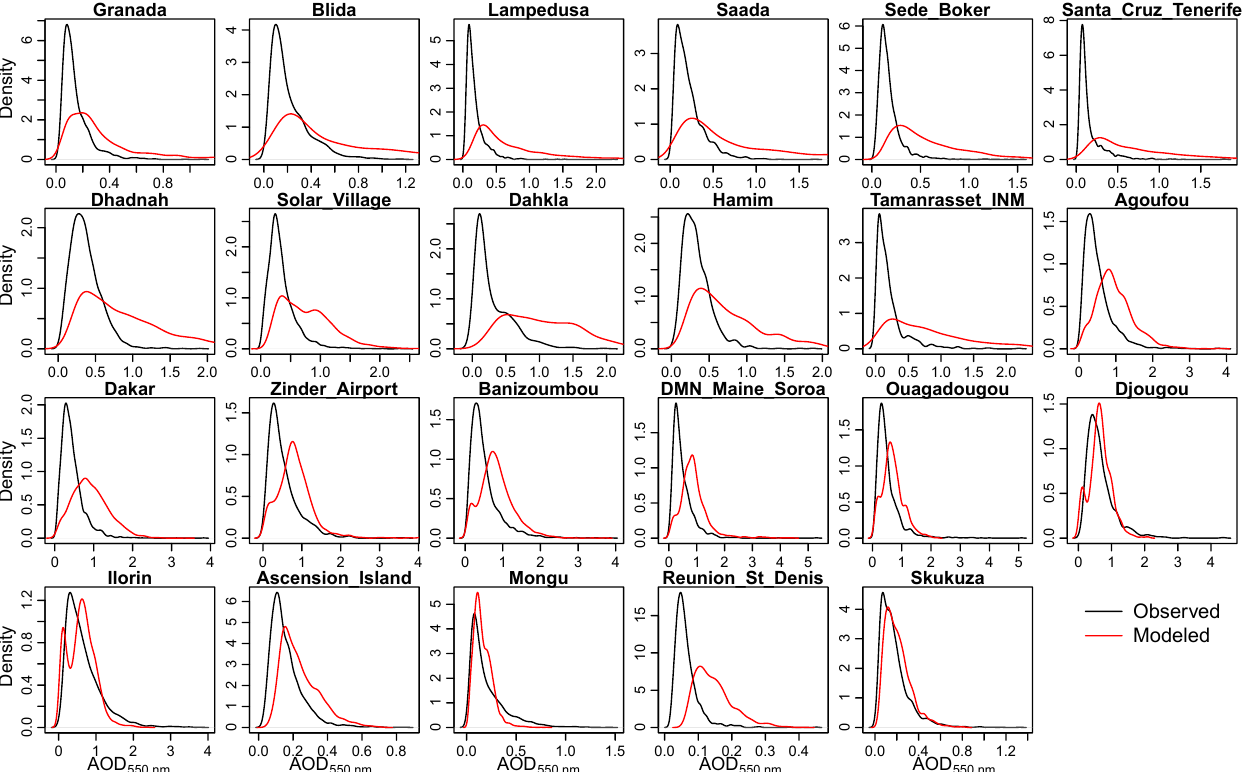
Figure 8. Comparison of the probability densities of modeled (red) and observed (black) daily average AOD 550nm at each